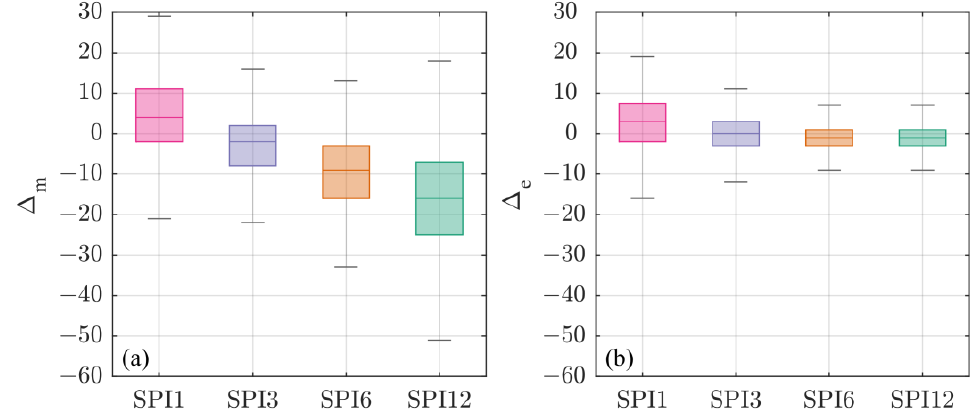
Figure 4. Variability of the differences Δ 𝑚 ( a ) and Δ 𝑒 ( b ) or each time scale. Table 5. Main statistics of drought characteristics, i.e., duration (D), severity (S), and interarrival time (T) for the standard and the best fit